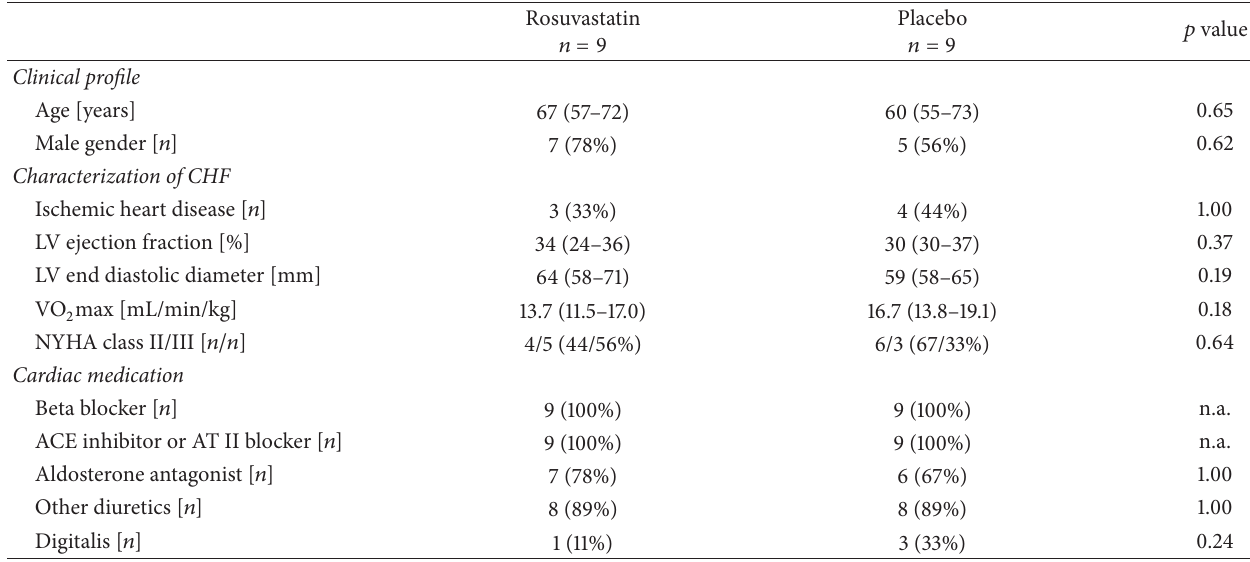
Table 1: Clinical characteristics.